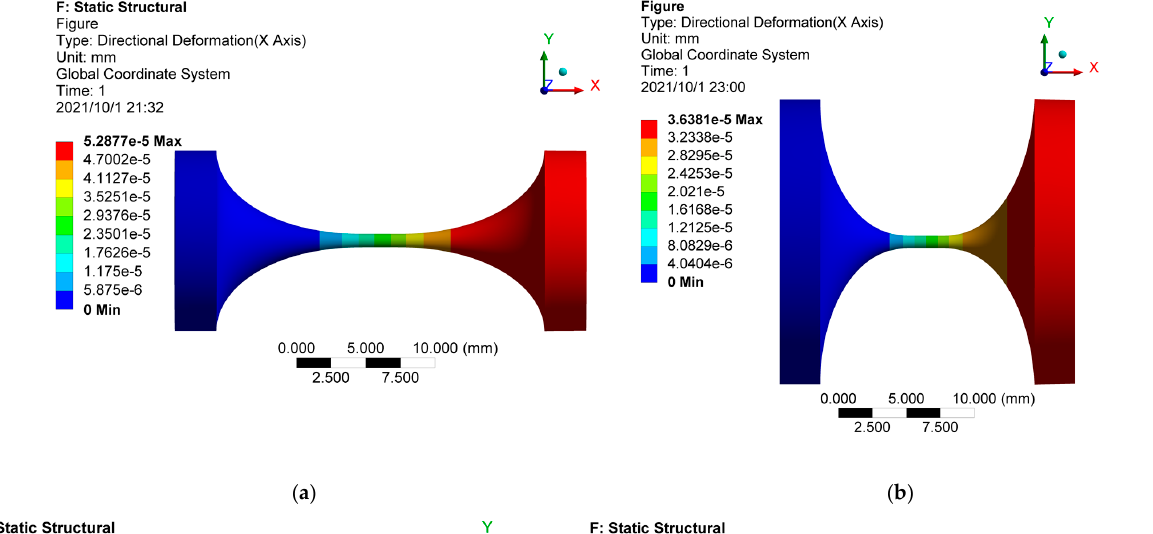
the right end edge; ( b ) Fixed support at the left end block and unit moment applied onto the right end edge.